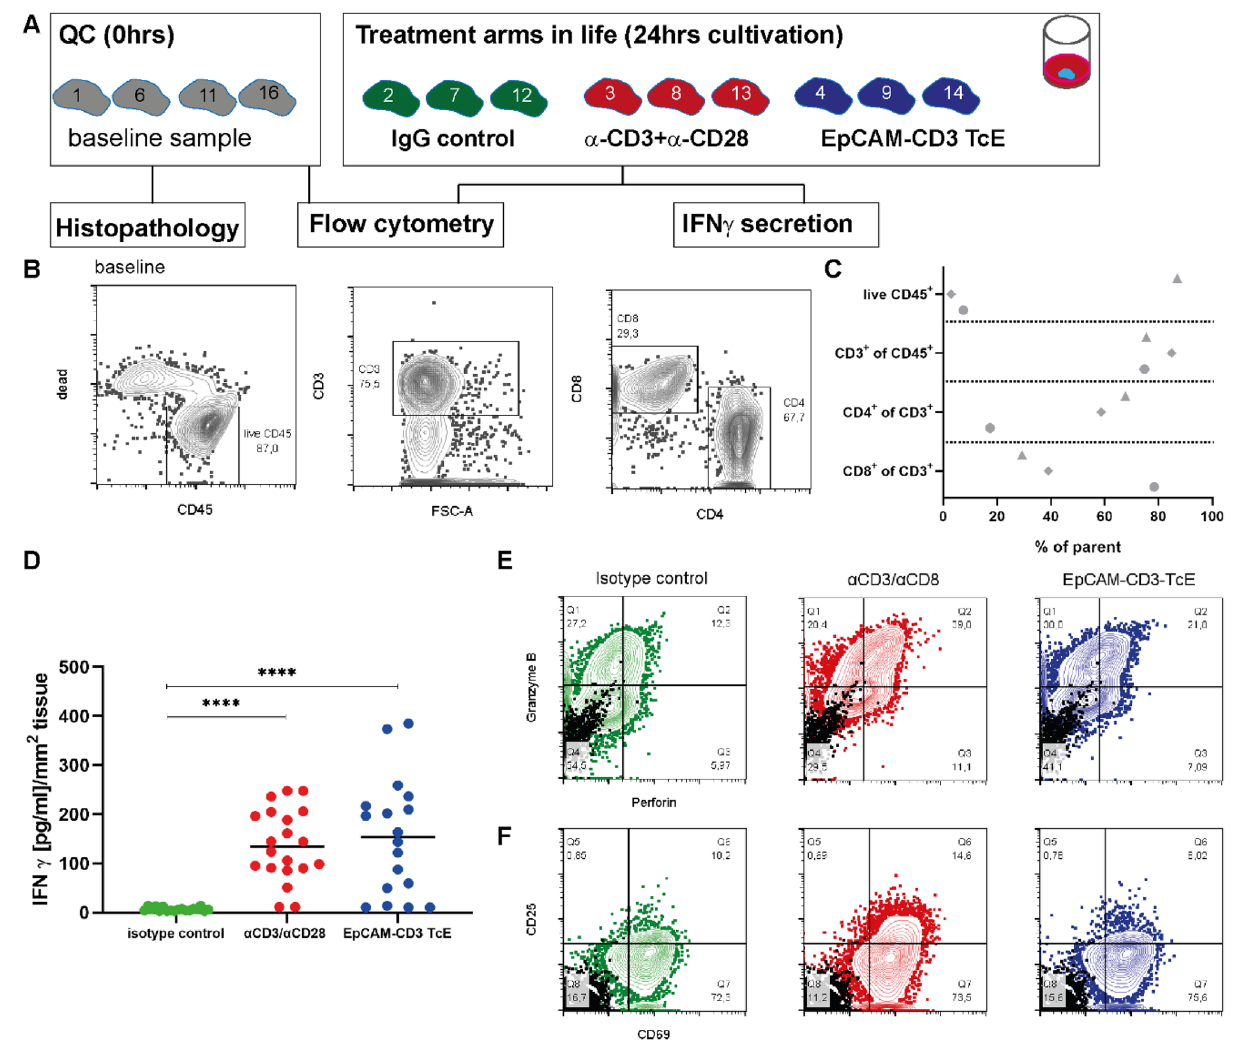
Figure 3. T-cells are functional and can be stimulated in HNSCCs ex vivo. ( A ) Following vibratome sectioning (200 μm) of fresh human HNSCC biospecimens, three slices from different layers were allocated to different treatment arms under free-floating conditions. Baseline samples from different levels were preserved for histopathological analyses. To stimulate T-cell activation, slices were incubated either with a combination of α-CD3/α-CD28 antibodies or with a bispecific T-cell engager (EpCAM-CD3 TcE). A treatment arm with unspecific IgG antibodies served as negative control. Flow cytometry was performed to analyze the immune cell content at baseline as well as effector and activation markers following treatments. IFNg secretion was measured in the supernatants of the different treatment arms. ( B ) Immune cell content at baseline was measured via flow cytometry (n = 3 HNSCCs). An exemplary flow cytometry plot of a representative baseline tumor sample (SC-090) is displayed. Frequency of living CD45+ve immune cells was identified in the single cell population and subsequently CD3+ve cells were gated. CD3+ve cell population was further divided into CD8 and CD4 expressing cells (detailed gating strategy see Suppl Fig. S3). The respective populations (displayed as % parental) were plotted in ( C ). Immune cell content of living CD45+ves (percentage of single cells of interest) varied between three analyzed HNSCCs (circle-SC084, rectangle-SC-087, triangle-SC-090), but the content of CD3+ves was quite similar. CD3+ve population contained both, CD4+ve and CD8+ve cells. ( D ) IFNγ secretion in the different treatment groups was normalized to the area of the slice cultures (μm 2 ). IFNγ in the supernatants was significantly increased either following α-CD3/α-CD28 or EpCAM-CD3 TcE treatment (n = 3 HNSCCs). IFNγ secretion was measured in technical duplicates. Student’s t test was performed, ****p < 0.0001. Time point of analysis was 24 h post treatment. ( E , F ) Flow cytometric analysis of T-cell (CD8) activation molecules (CD25, CD69) and effector molecules (Granzyme B, Perforin) at 24 h. An example of a representative tumor sample (SC-090) is displayed. The quadrant gate was drawn using samples stained with isotype control antibodies conjugated with the respective fluorochromes (black) to exclude unspecific background. In comparison to the isotype-treated control samples, Perforin/Granzyme B double positive populations were increased after α-CD3/ α-CD28 or EpCAM-CD3 TcE stimulation. CD69/CD25 double positive populations were slightly increased upon stimulation. Technical triplicates were